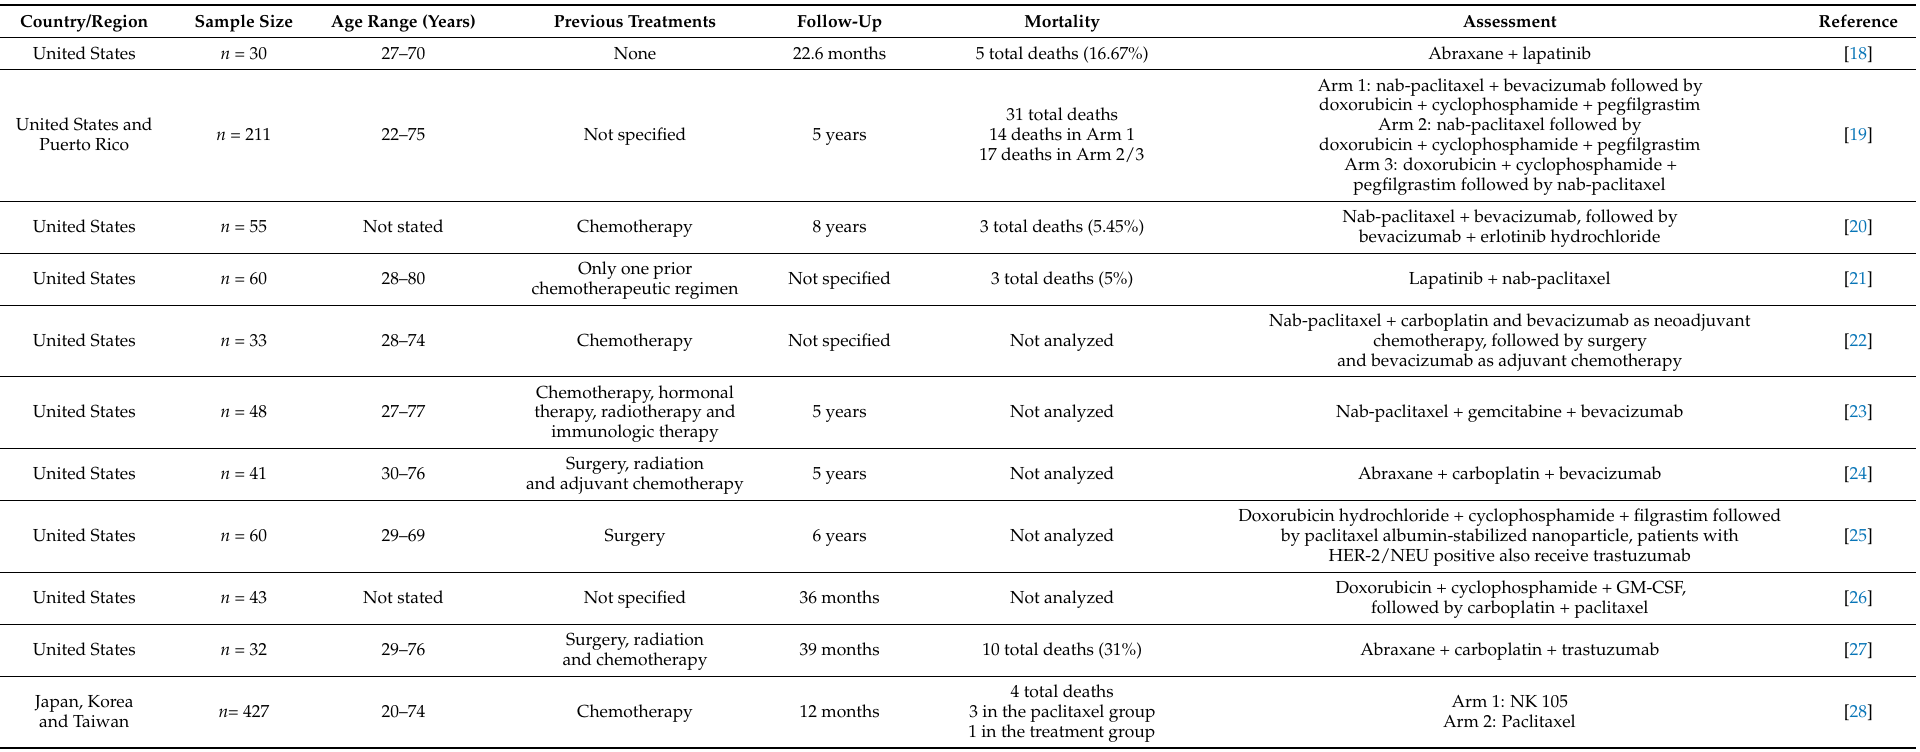
Table 2. Characteristics of included clinical